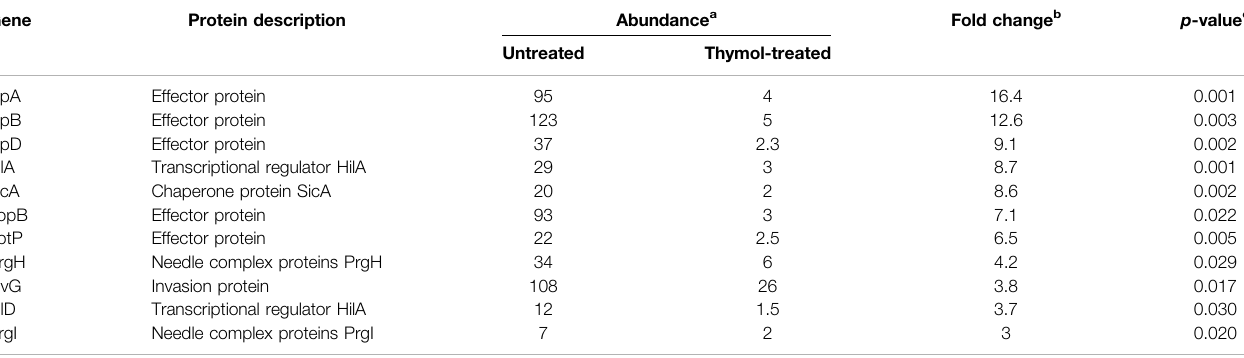
TABLE 4 | Thymol affects the abundance of Salmonella virulence